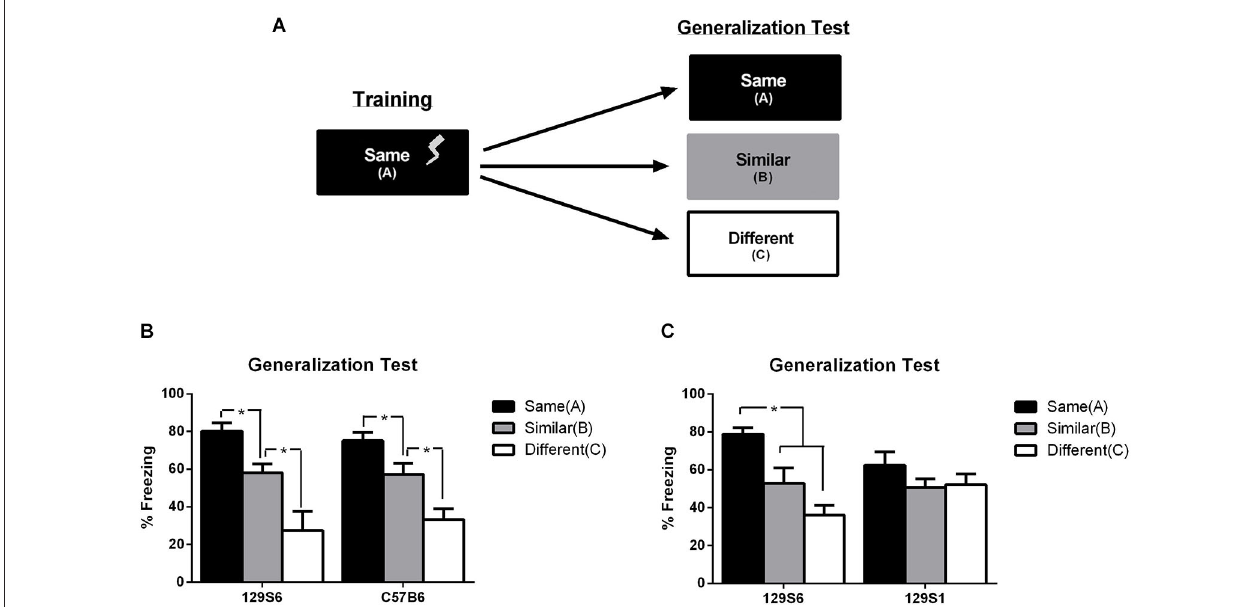
context (C57B6 n = 8, 129S6 n = 6), and low levels of freezing in the different context (C57B6 n = 8, 129S6 n = 7). (C) In a separate experiment, fear generalization in the 129S6 and 129S1 substrains were compared. Consistent with previous reports, the 129S1 mice exhibited similar levels of freezing regardless of the context (same, n = 8; similar, n = 8; different, n = 8). In contrast, and consistent with our previous experiment, the 129S6 exhibited graded levels of freezing in the three contexts (same, n = 8; similar, n = 8; different, n = 8). Data are represented as mean ± SEM. * p <